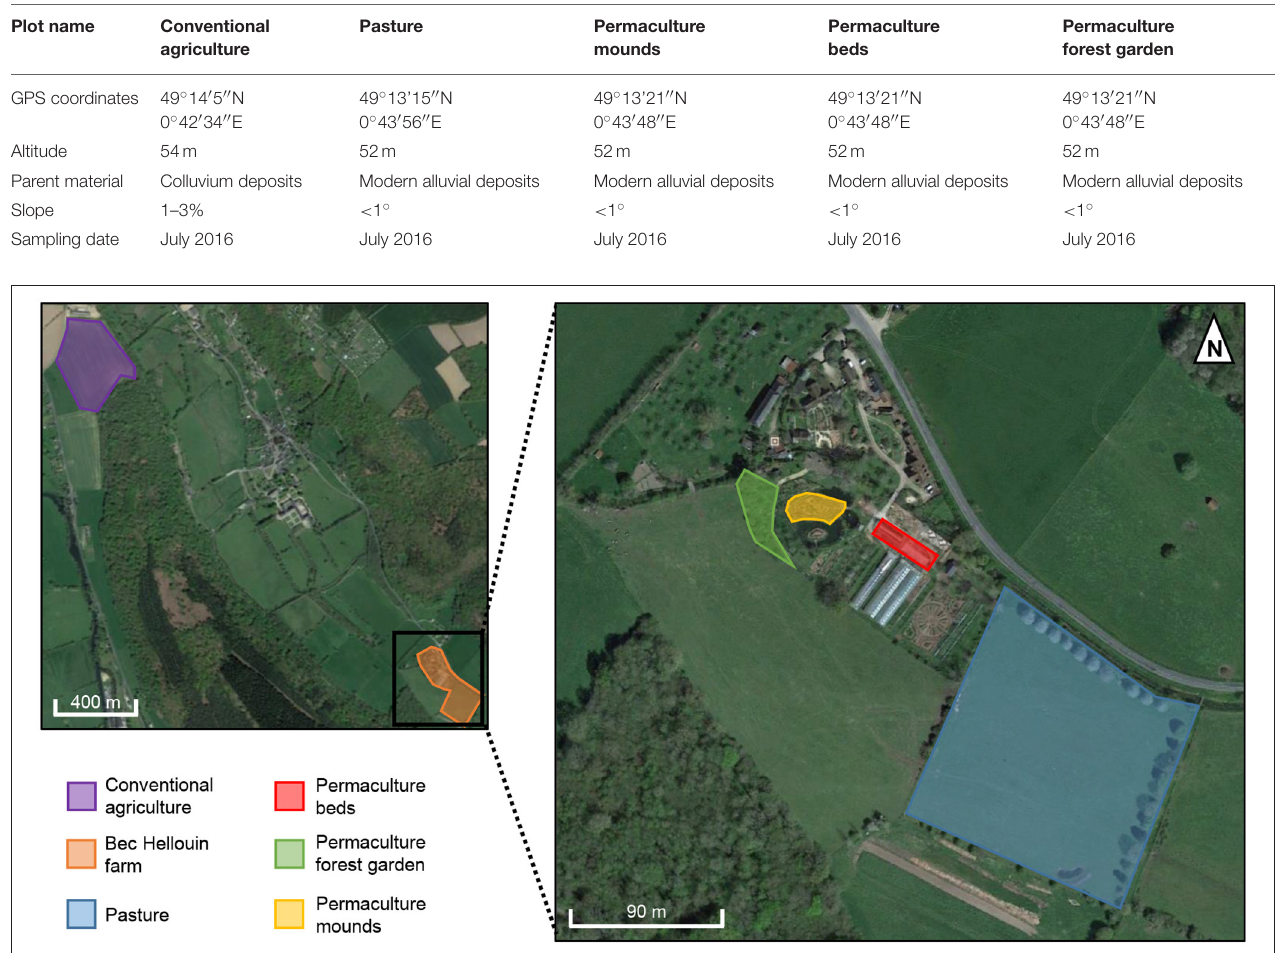
FIGURE 1 | Orthophotoplan of the studied